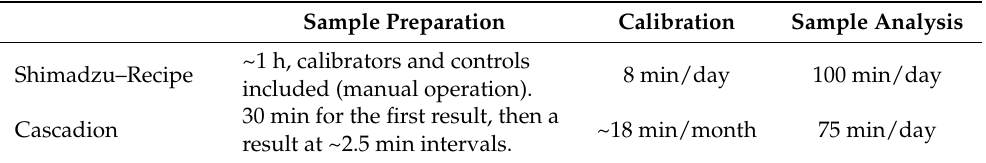
Table 2. Times for preparation, calibration, and analysis of 50 samples/day are shown both for Shimadzu–Recipe and for Cascadion. Sample Preparation Calibration Sample Analysis